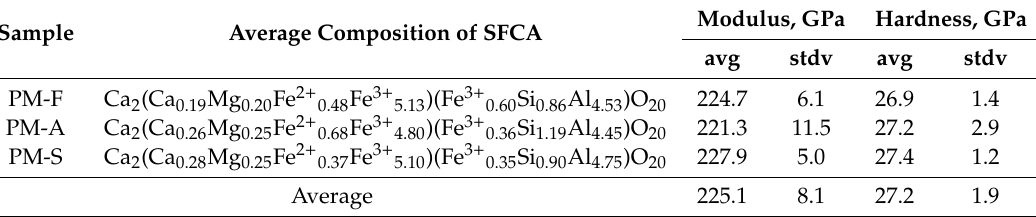
Table 5. Averaged results of the